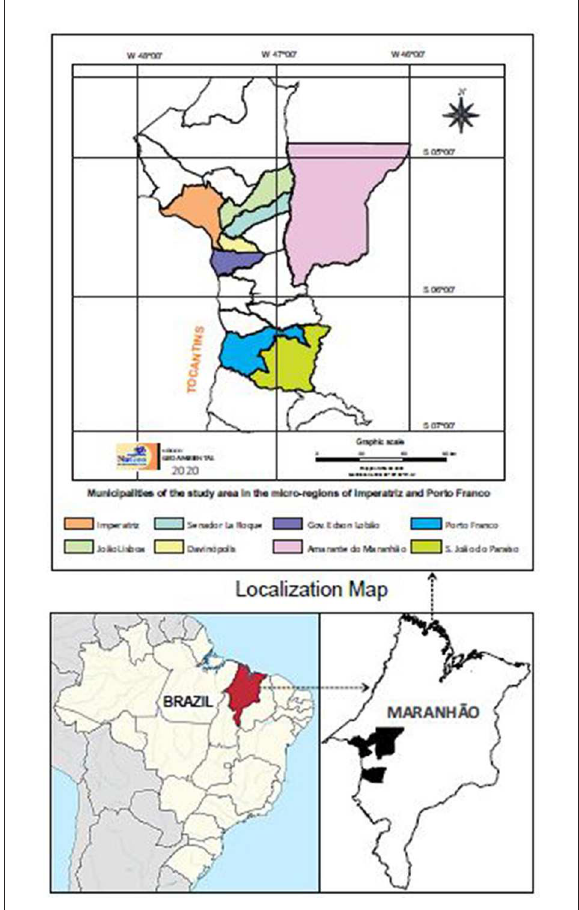
FIGURE1 Map showing the location of municipalities where the sample collection was carried out. Locations are indicated by color.